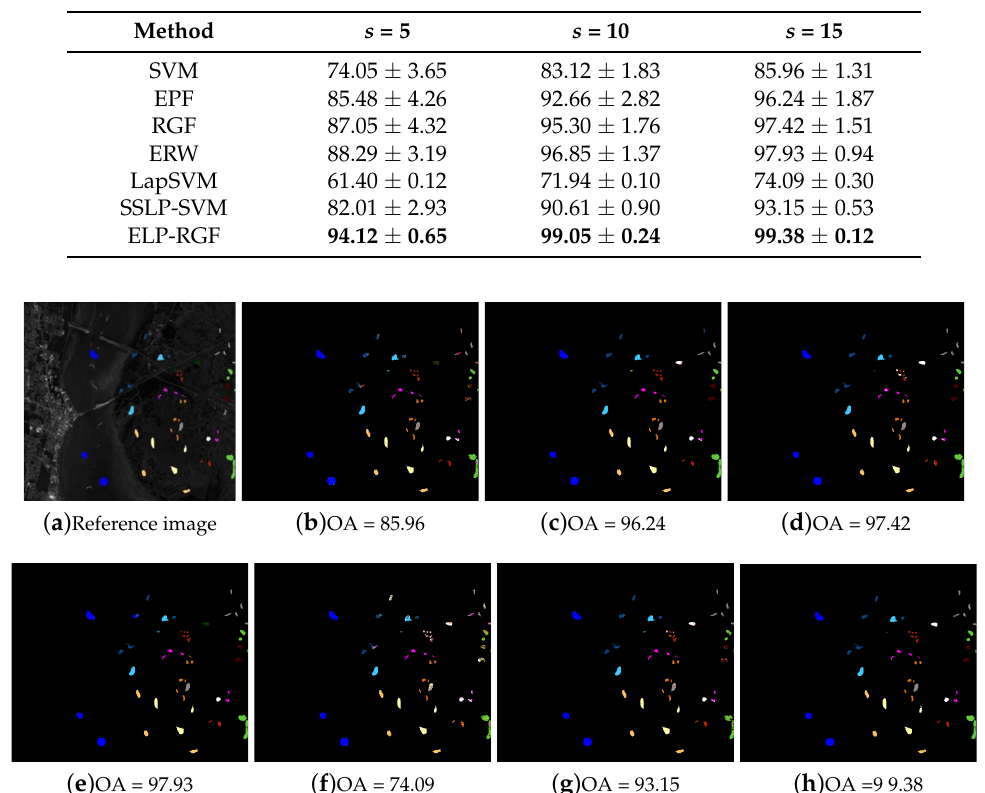
Figure 11. Classification maps of different methods for the Kennedy Space Center image. ( a ) Reference image; ( b ) SVM method; ( c ) EPF method; ( d ) RGF method; ( e ) ERW method; ( f ) LapSVM